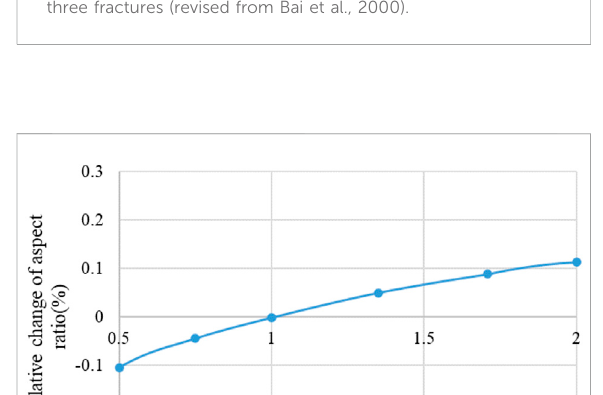
FIGURE 15 FEM model and its boundary conditions of layered shale. (A) Uncon fi ned fracture model; (B) con fi ned fracture model with three fractures (revised from Bai et al., 2000).